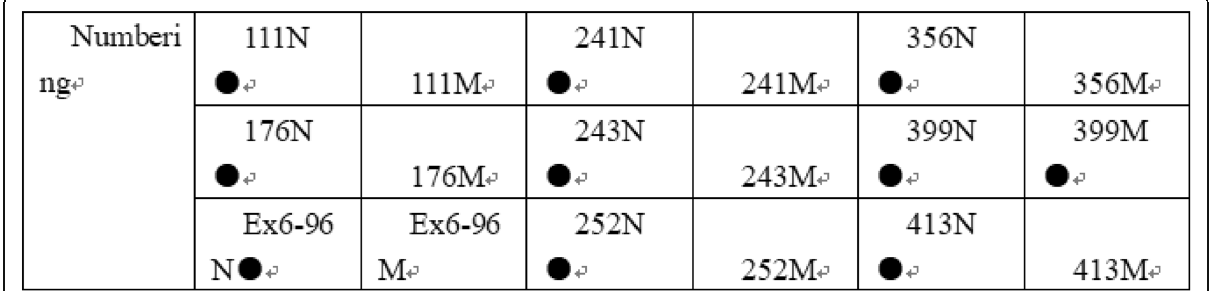
Fig. 1 Schematic layout of the membrane probe